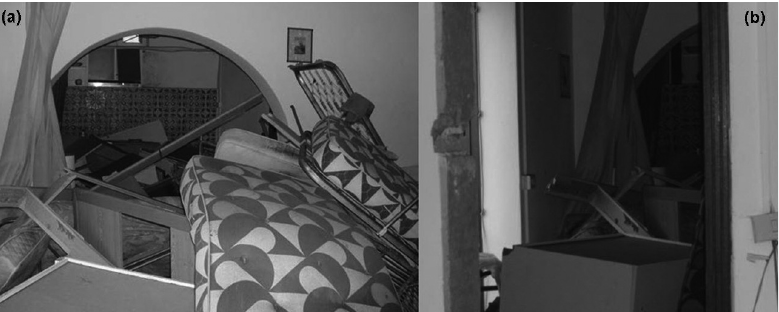
Fig. 10. Two pictures of building #3 (Punta Lena, Stromboli – Fig. 6) taken after the 2002 tsunami. (a) Damage to the interior. (b) A view of the main entrance of the building, where the door have been ripped off the wall. The PTVA-3 Model assigned to building #3 an “average” RVI